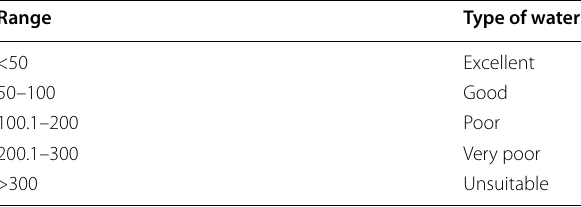
Table 2 Water quality classification for drinking purposes based on the WQI values (Boateng et al. 2016) Range